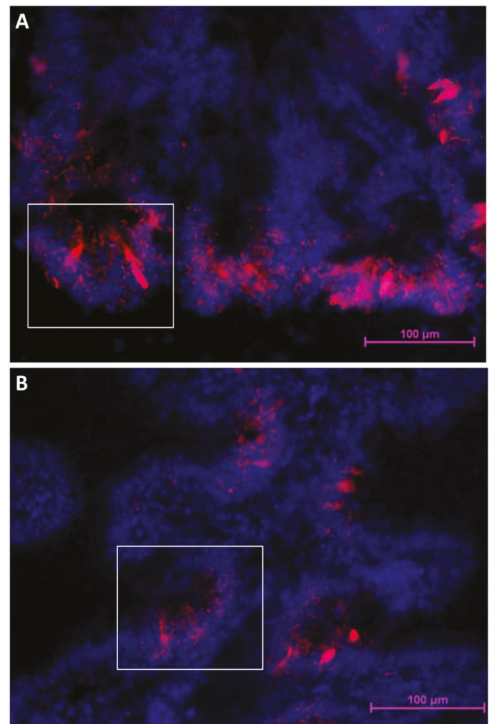
Figure 11. Rainbow trout columnar epithelial cells showing an intense sox9 expression at the fold base in the second segment of the mid-intestine ( A ) and at the base of the folds protruding from the complex folds ( B ).